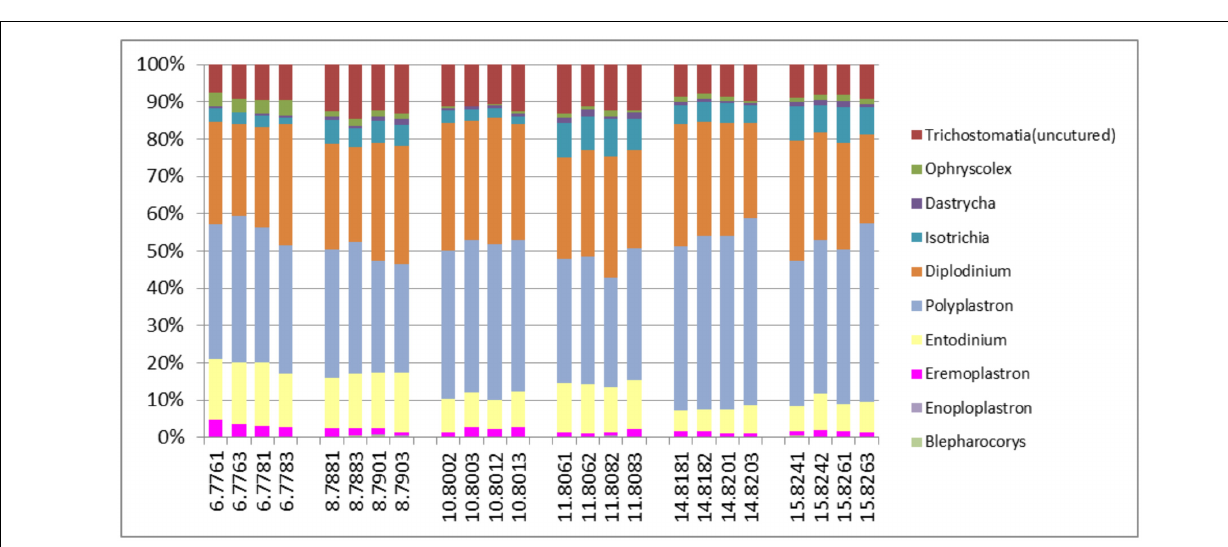
FIGURE 6 | Taxonomic distribution of the Protozoan community in the V4 region extracted from total rRNA analysis, of solid-phase rumen contents of 6 cattle, 2 samples from each, analyzed in